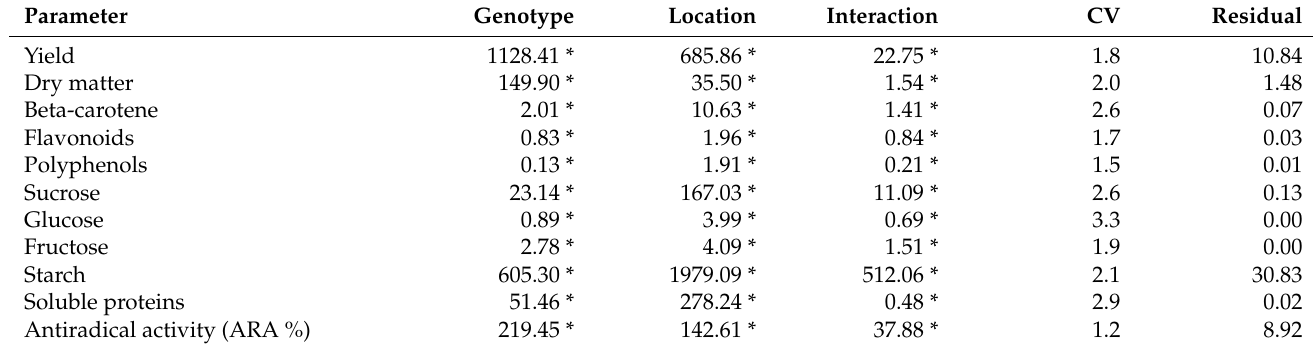
Table 2. Two-way ANOVA of nutraceutical traits and yield of sweet potato genotypes at the investi- gated locations; * = p <